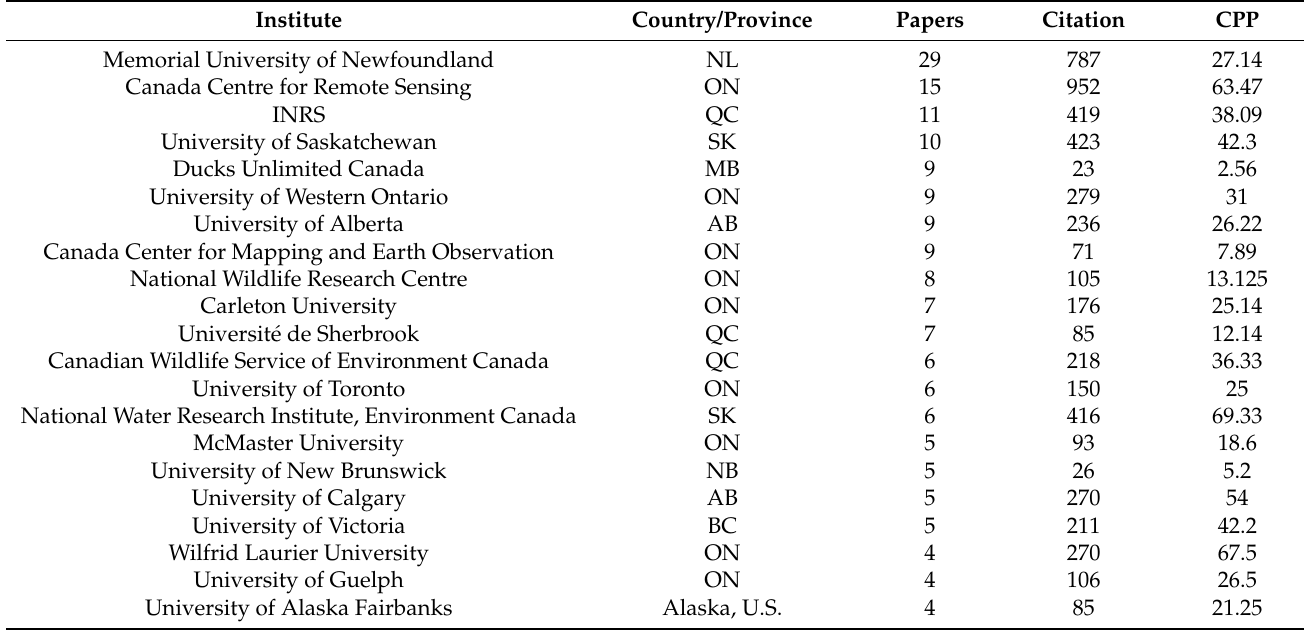
Table 3. The detailed information of affiliations